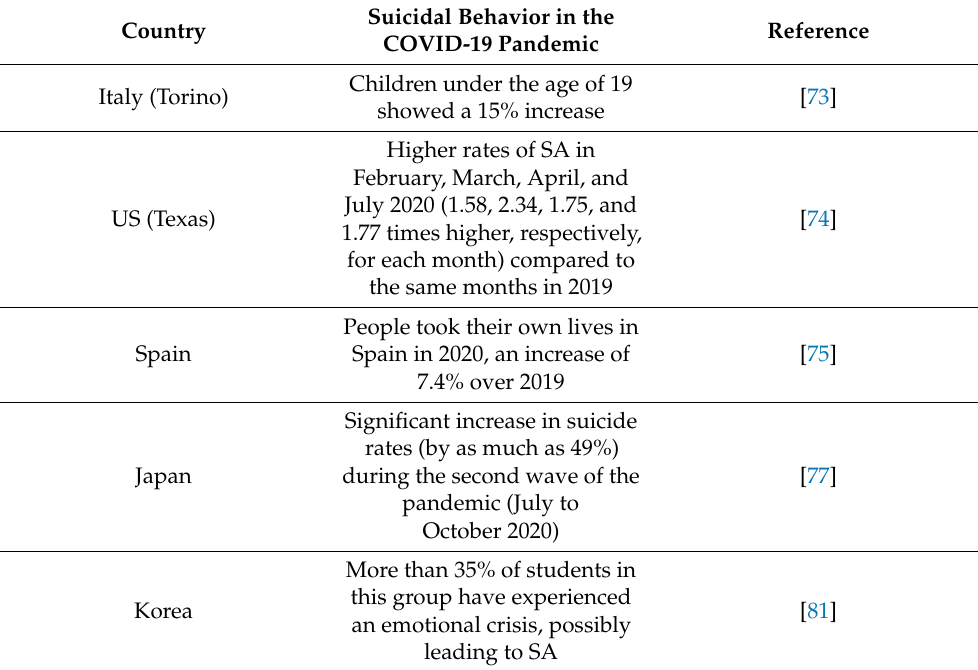
Table 2. Number data of suicidal behaviors during the COVID-19